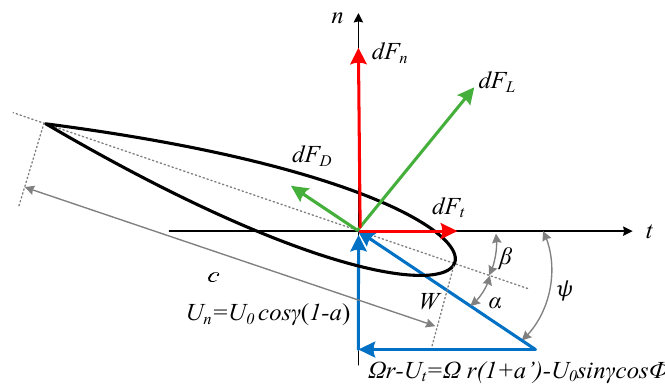
Figure 2. Velocities and forces acting on a cross-sectional blade element.